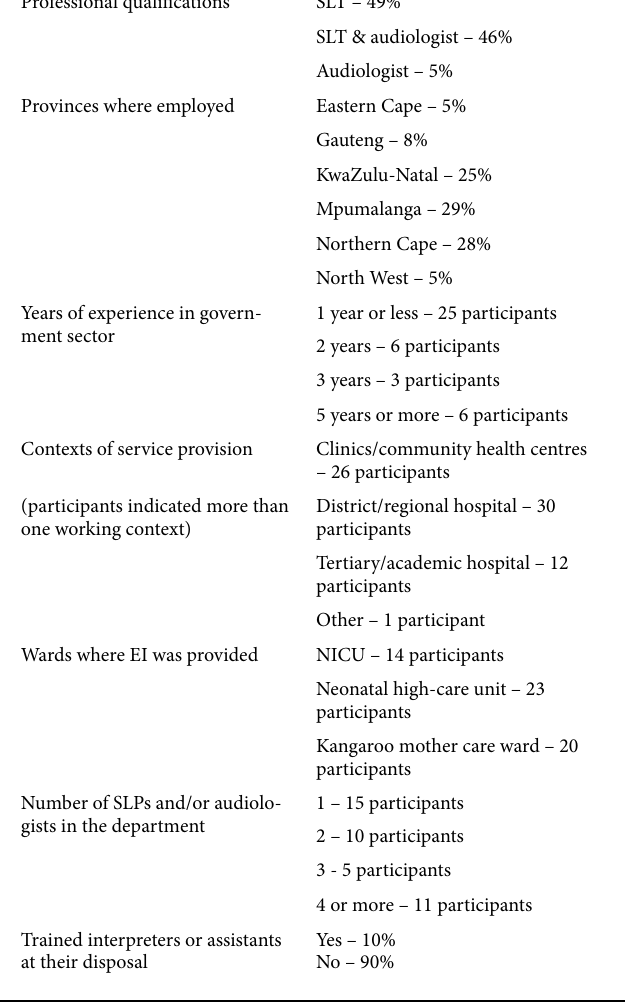
Table I. Characteristics of the